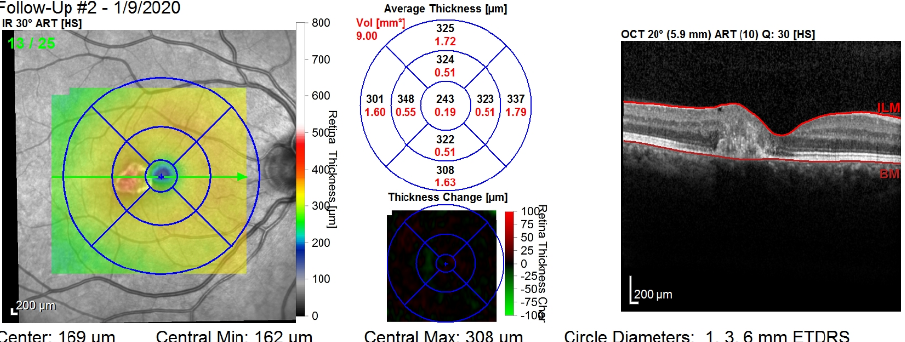
Figure 1. The third visit, i.e., follow-up (#2), of a patient, right eye only. The right column shows that the values are computed on all of the layers of the retina: between the top layer (i.e., ILM) and the bottom layer (i.e., Bruch’s membrane—BM). The middle column shows nine values for the retinal thickness (black color), and nine values for the retinal volume (red